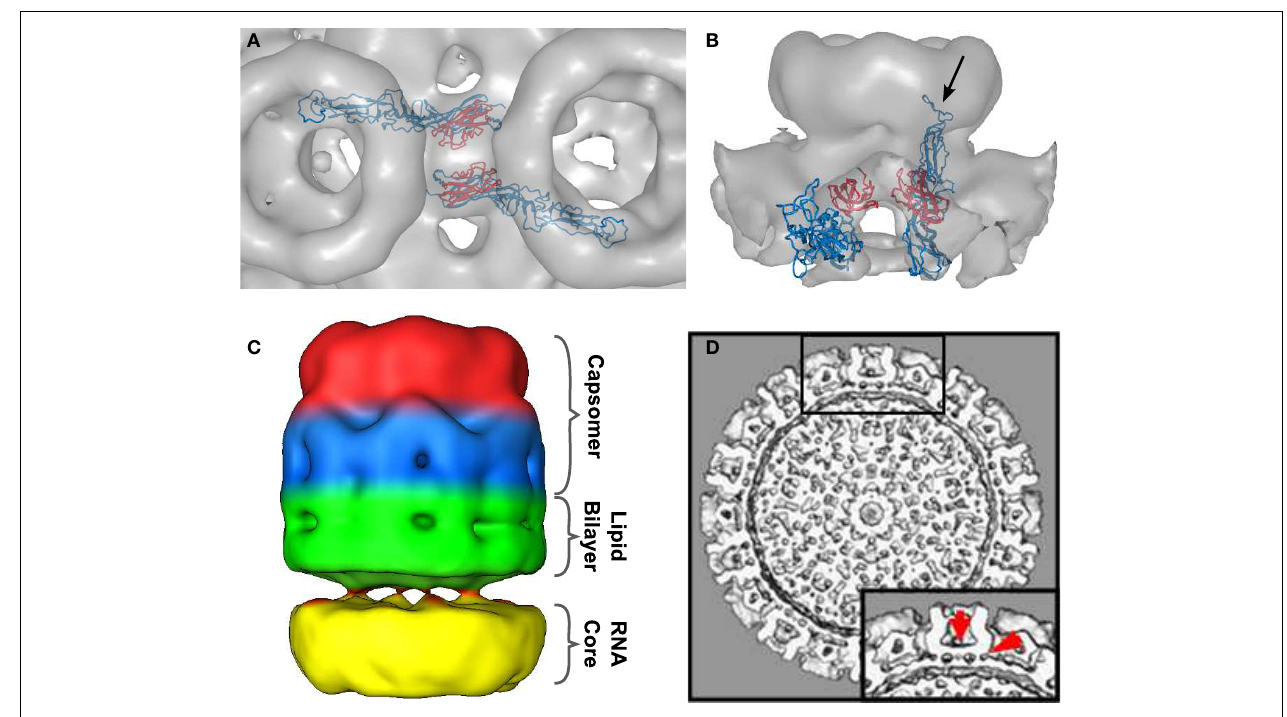
capsomer base in blue (representing mainly Gc molecules), the lipid envelope in green, and the density corresponding to the RNP core is shown in yellow. Densities spanning the gap between the lipid bilayer and the RNP core are representing the glycoprotein cytoplasmic tails. (D) Surface-shaded representation of the central section of the RVFV cryoEM map viewed along the fivefold orientation.The sections show glycoprotein protrusions on virus surface, lipid bilayer, and RNP core. In the lower right corner a blow-up of the boxed area is shown. Red arrows point to clearly defined densities spanning the lipid bilayer.These densities represent glycoprotein transmembrane domains and are located either on the outer edge of the capsomer or directly beneath the connecting